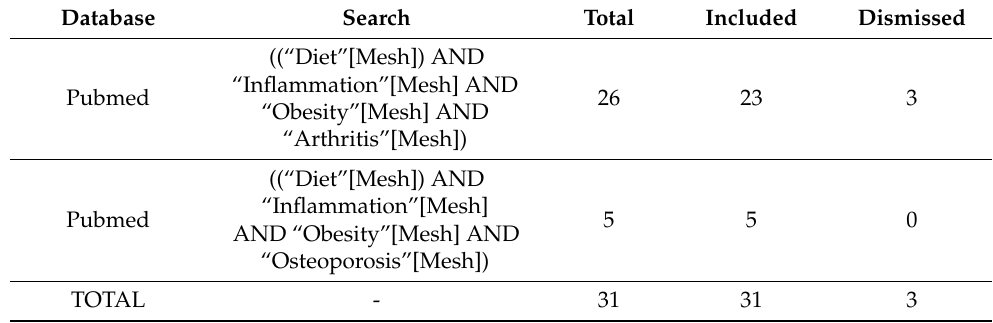
Table 2. The searches performed, with the total results, the accepted results, and the dismissed